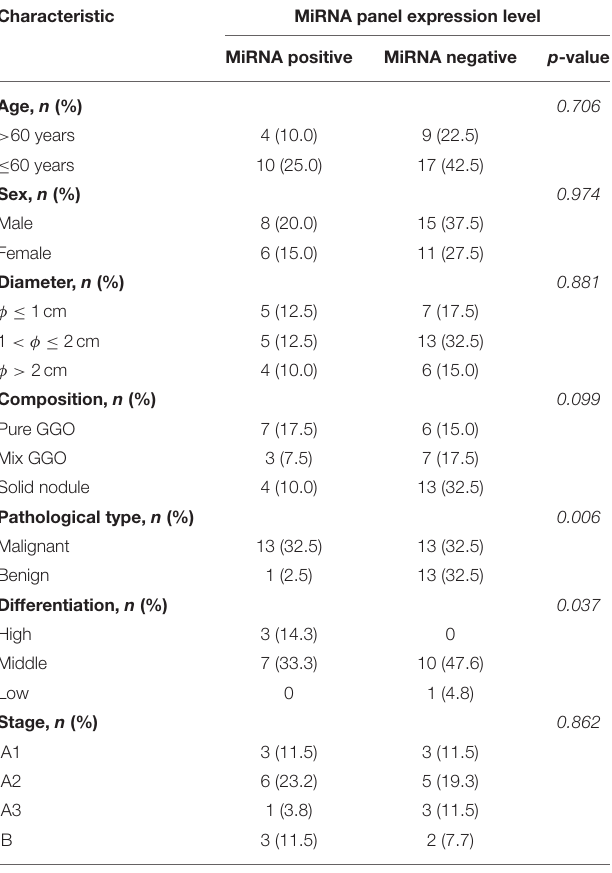
TABLE 3 | Correlation between miRNA expression levels and clinicopathological characteristics. Characteristic